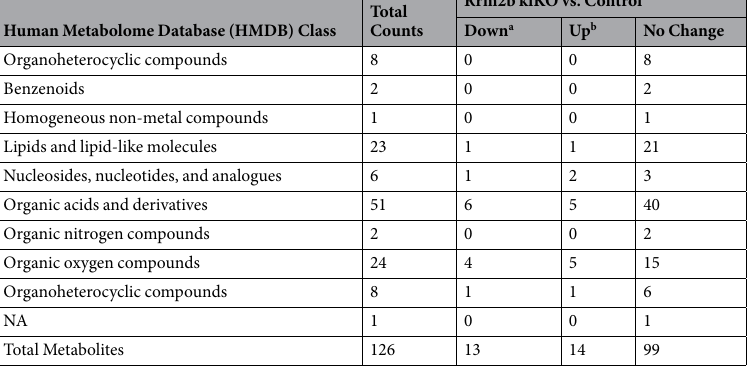
Table 2. Metabolites identified from mouse kidney with GC-TOF-MS. a Rrm2b kiKO has lower